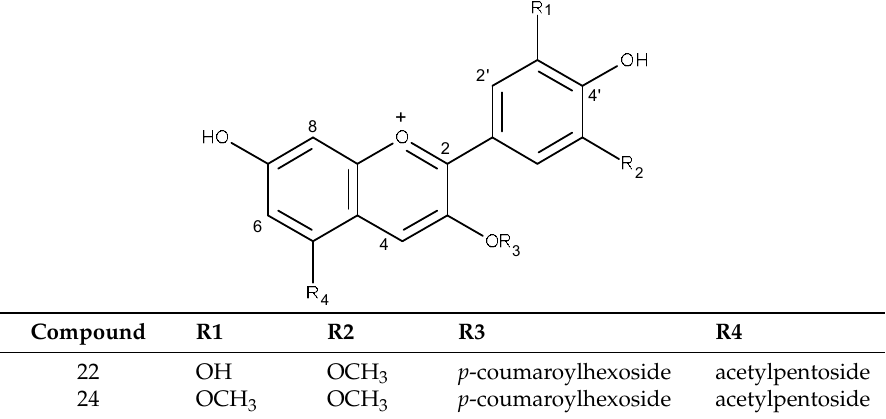
Table 4. Anthocyanin structures and substituents groups in T. pulchra flower extracts identified by UPLC-PAD-ESI-QTOF-MS.